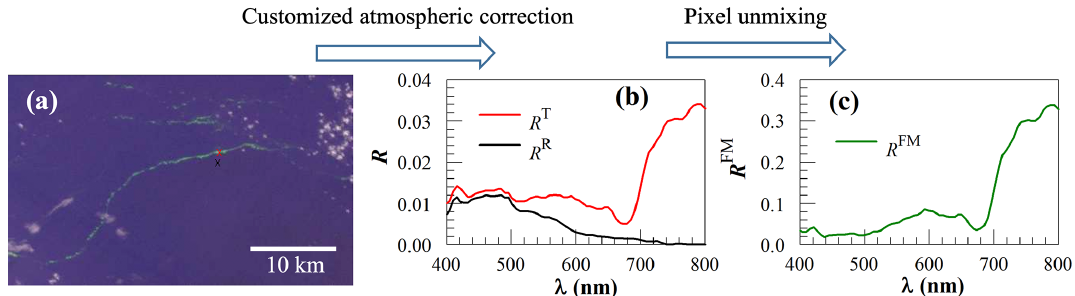
Figure 1. Demonstration of how surface reflectance of floating matter ( R FM ) is derived. (a) FRGB image on 1 July 2012 showing sev- eral greenish image slicks in the Amazon River plume. The image covers a region of about 40km × 24km, with the target (6.65914 ◦ N, 51.2395 ◦ W) and reference (6.64847 ◦ N, 51.2411 ◦ W) pixels marked with a red × and a black × , respectively. (b) Their corresponding R T and R R , with the latter derived from SeaDAS and the former derived from a nearest-neighbor atmospheric correction. (c) R FM derived from R T and R R using Eq. (4), with χ being estimated to be